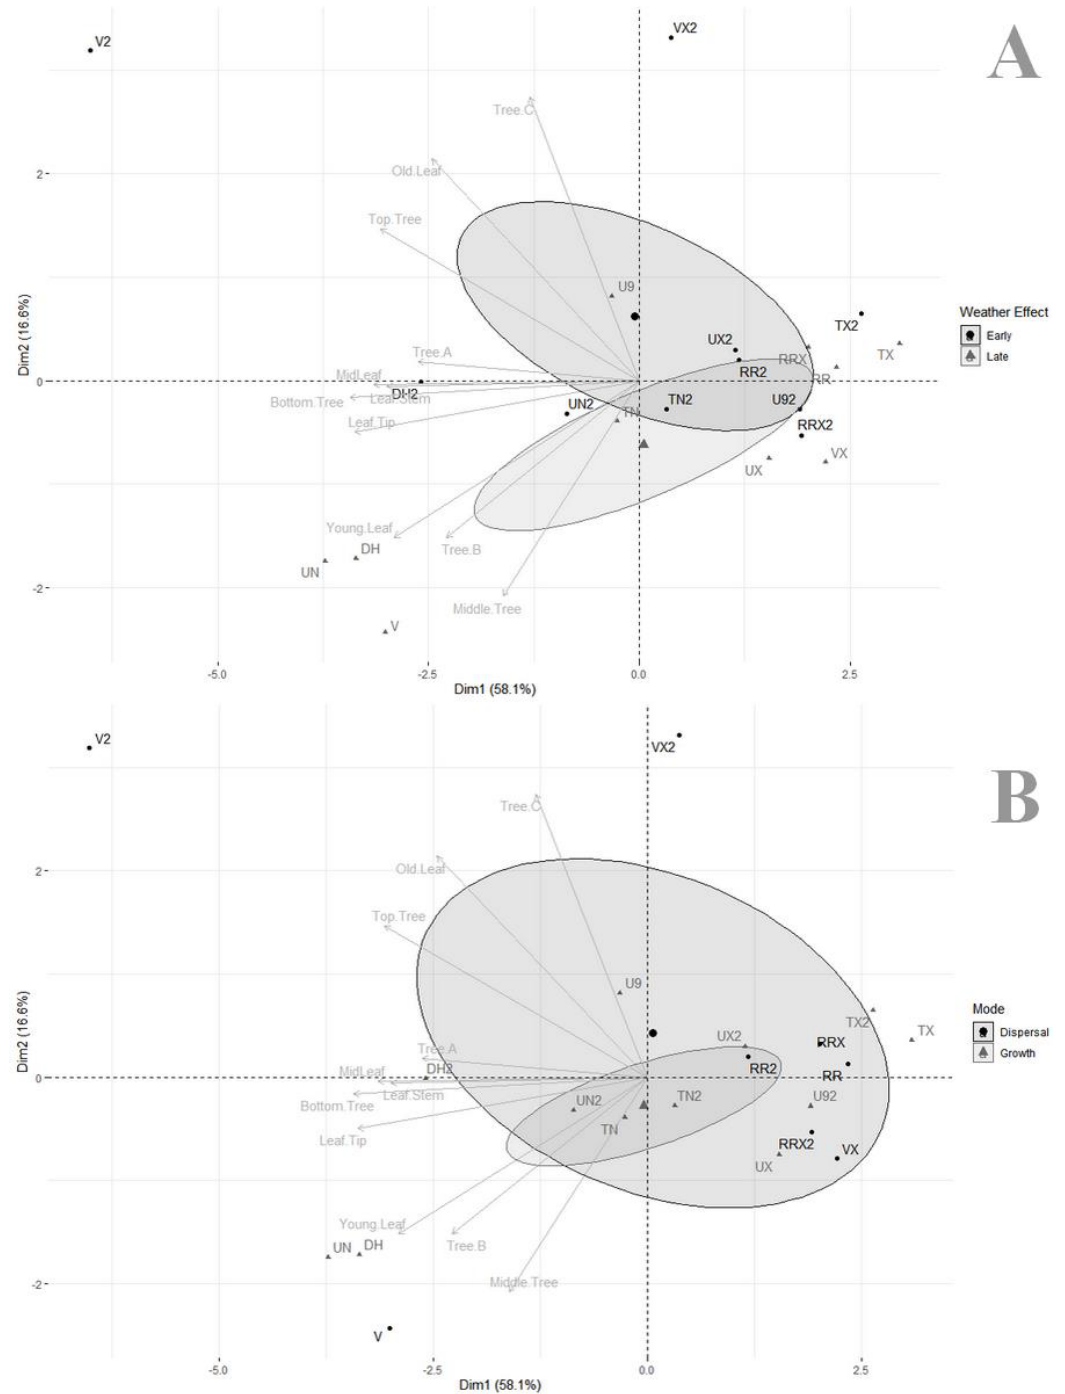
Figure 3. Principal component analyses of covariate impact in random forest models, illustrating impact of ( A ) weather effect (early vs. late) and ( B ) mode of impact (involved in dispersal vs. involved in fungal growth) (data from Table 2).